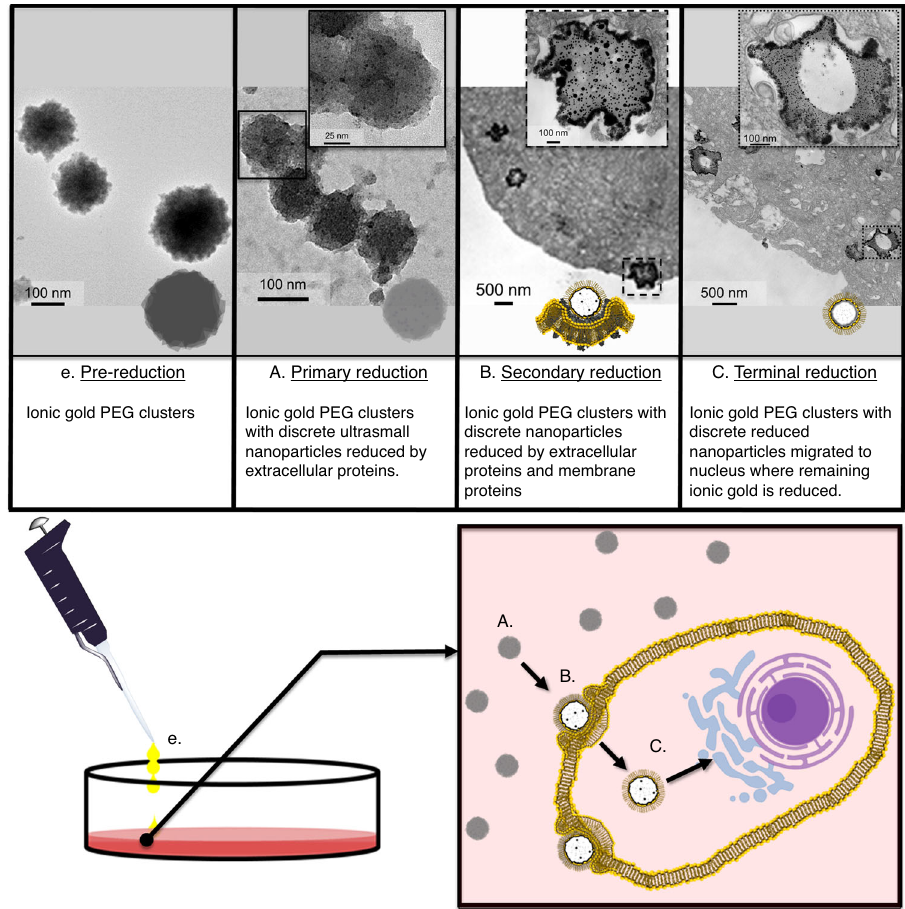
Fig. 4 Scheme of progressive reduction process. Pictorial diagram for the intracellular formation of gold nanoparticles via Au – PEG clusters throughout their migration to the nucleus with TEM images of respective reduction